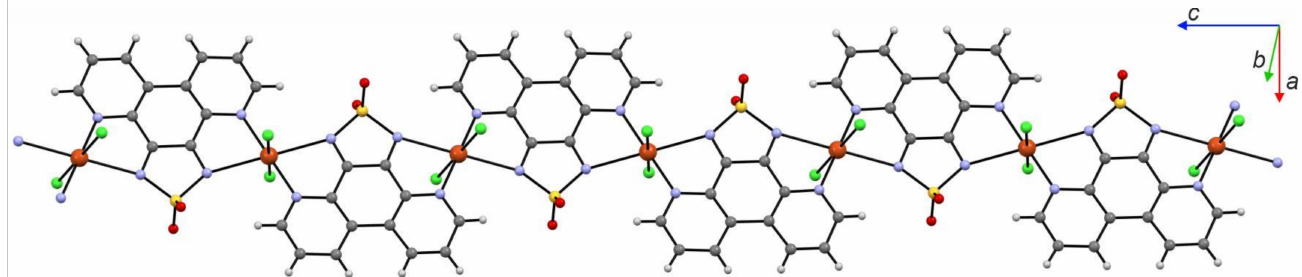
Figure 12. Schematic structure of {CuCl 2 (4,7-tdapO 2 )} n chain with 4,7-tdapO 2 molecules acting as diamagnetic bridges between the Cu II metal ions [42].